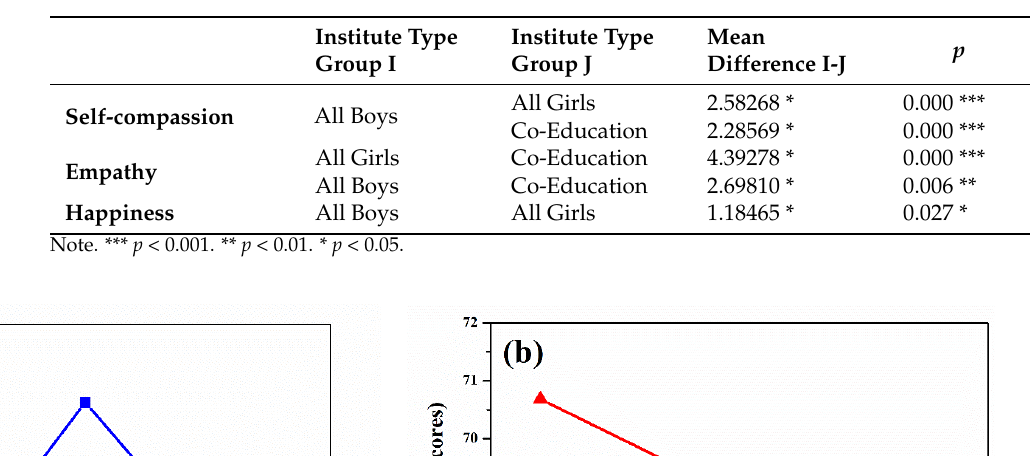
Table 7. Post hoc analysis (LSD) of late adolescents’ self-compassion, empathy, and happiness with institute type ( N = 566).